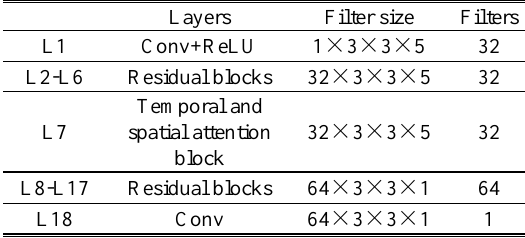
Table 1. Detailed configurations of the proposed MSAR-